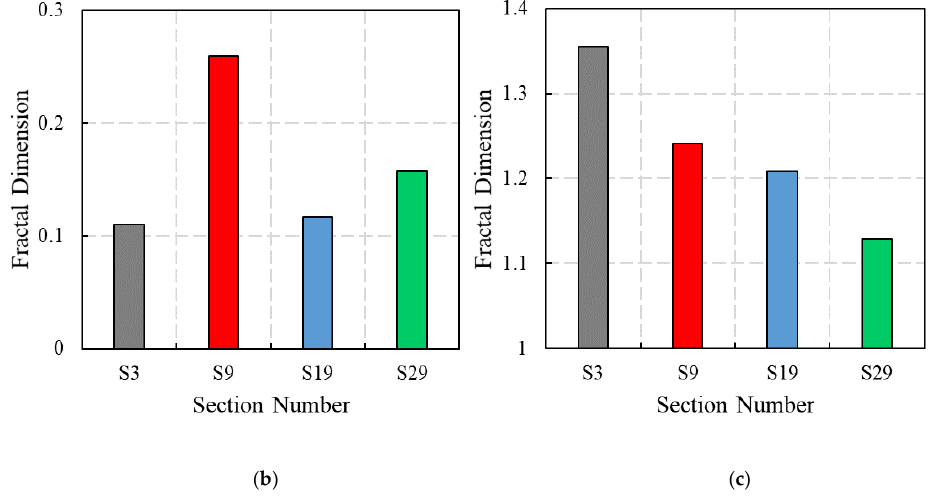
Figure 16. Comparison of D a at eight moments on four special sections. ( a ) Da at eight continuous different moments on four special sections; ( b ) Maximum-minimum difference of D a ; ( c ) Average value of D a .